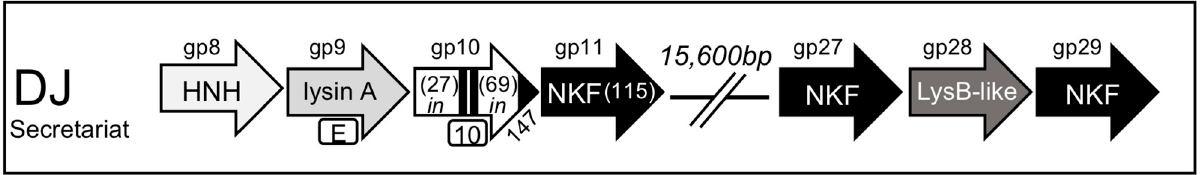
Fig 6. Genomic organization of a lysis cassette with a lysA and single transmembrane gene and a predicted lysB at distal location. The genomic structure is shown and the key to the schematic is presented in Fig 1. The direction of transcription of each gene is represented by the arrowhead.